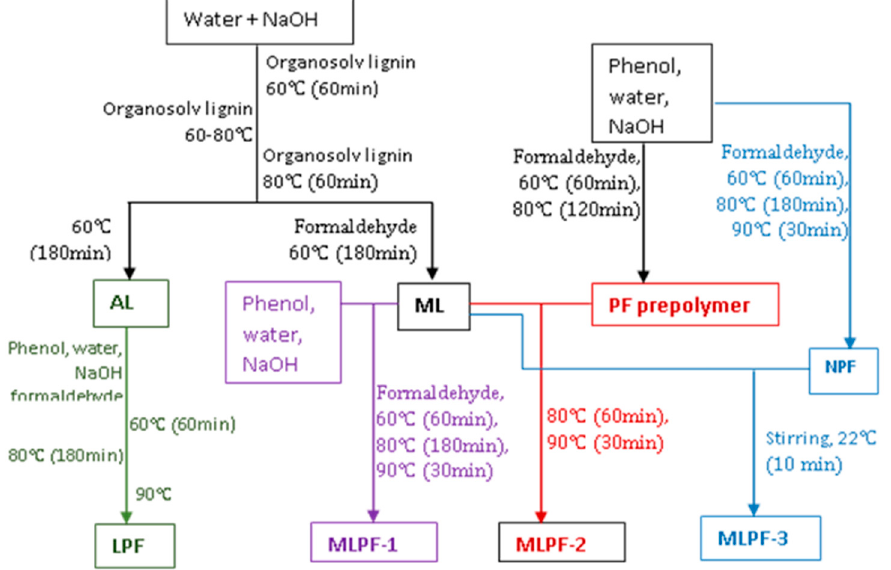
Figure 1. Diagram for phenolic adhesives preparation.